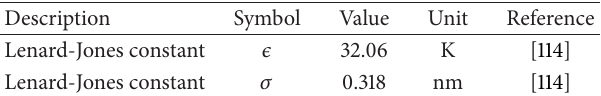
Figure 9: Lennard-Jones potential of the carbon-hydrogen interac- tion. Values for 𝜖 and 𝜎 were taken from [114]. Table 5: Lenard-Jones constants for the carbon-hydrogen interac-